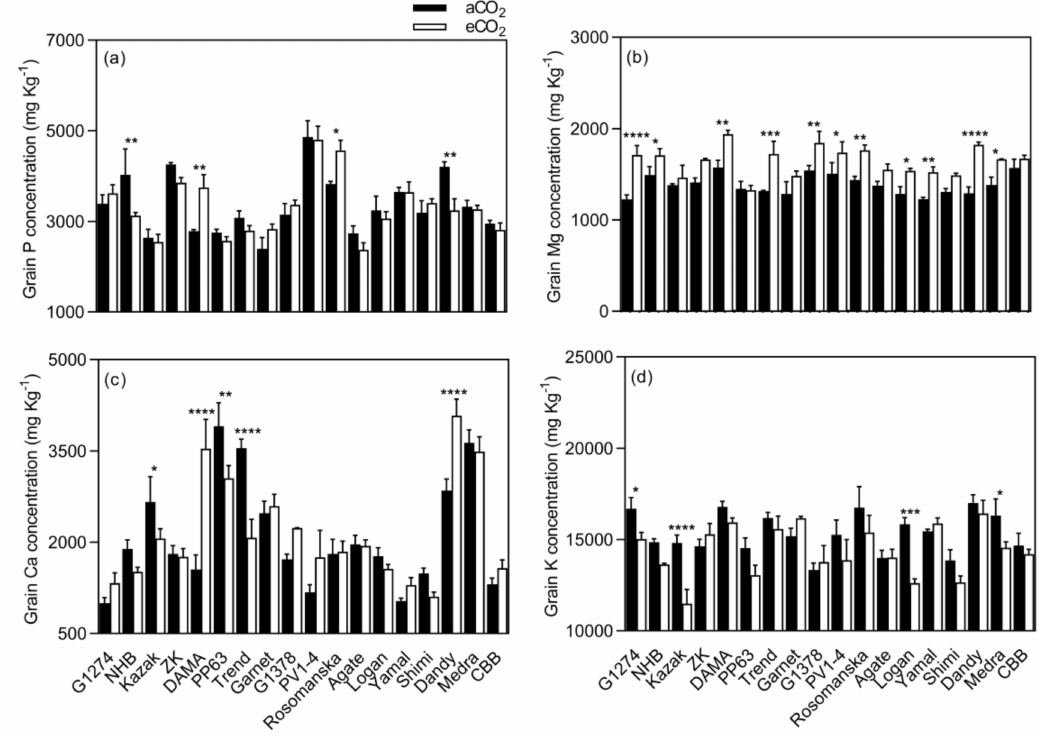
Figure 9. Grain macronutrient ( a – d ) concentrations of soybean grown under aCO 2 (400 ppm) and eCO 2 (800 ppm). Each bar represents the mean ± SE ( n = 10 plants). * p < 0.05; *** p < 0.001 significance